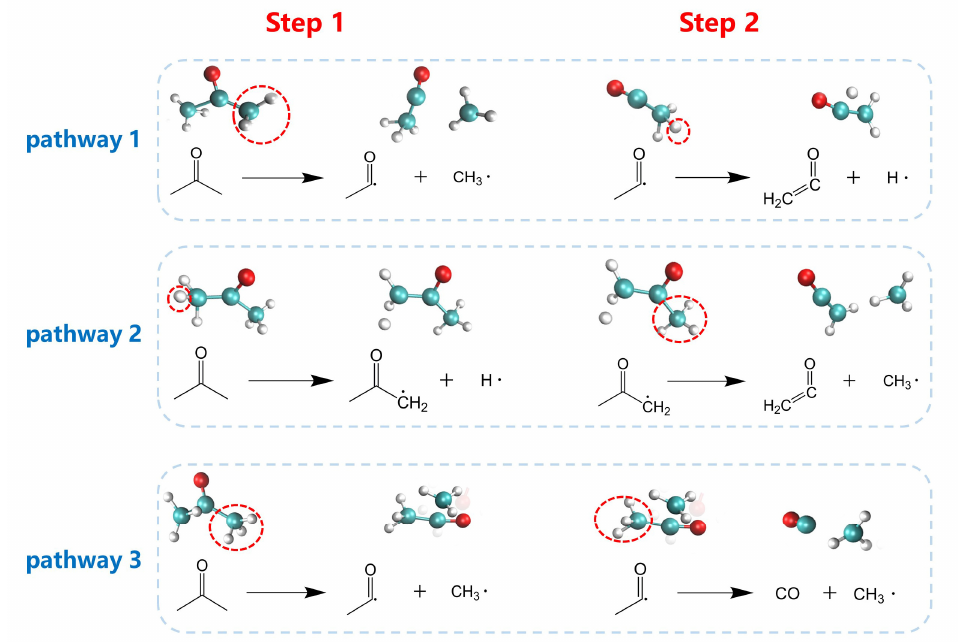
Figure 10. Major reaction pathways of acetone during the aging